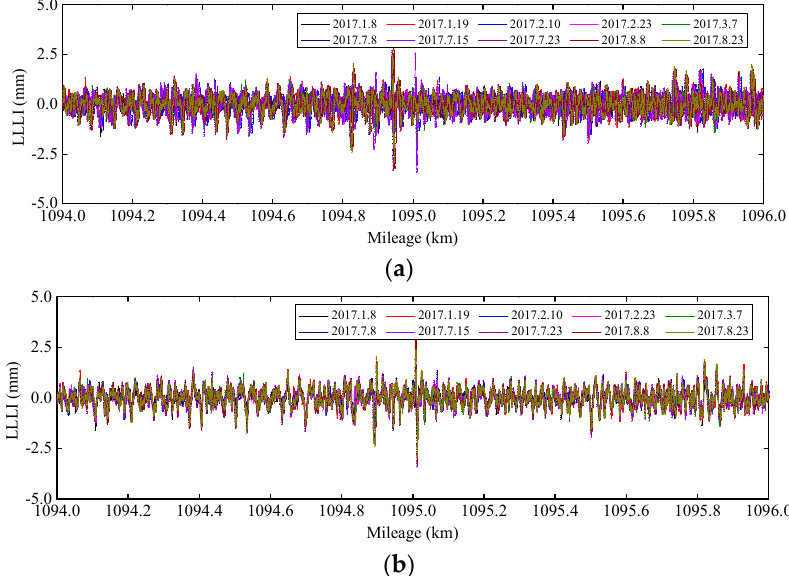
Figure 5. The inspection data before and after alignment. ( a ) The data before alignment; ( b ) The data after alignment.